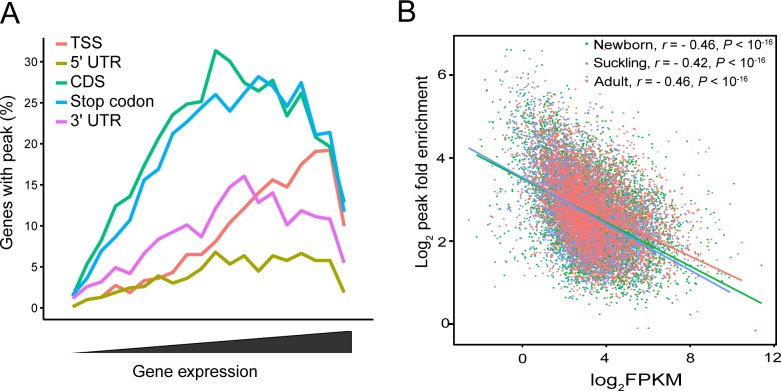
Relationship between m6A methylation and expression of modified genes.(A) Fraction of genes with m6A peaks in each of the segments as a function of expression level. Most of the modified genes were expressed at moderate levels. Genes expressed at the two extremes were less methylated. (B) Plot of m6A peak enrichment and mRNA abundance in the three stages. Obvious negative correlation between m6A peak enrichment and modified mRNA abundance was found (Pearson’s r = -0.47 to -0.42, P < 10−16). Lines represent the linear trend for the obtained values.